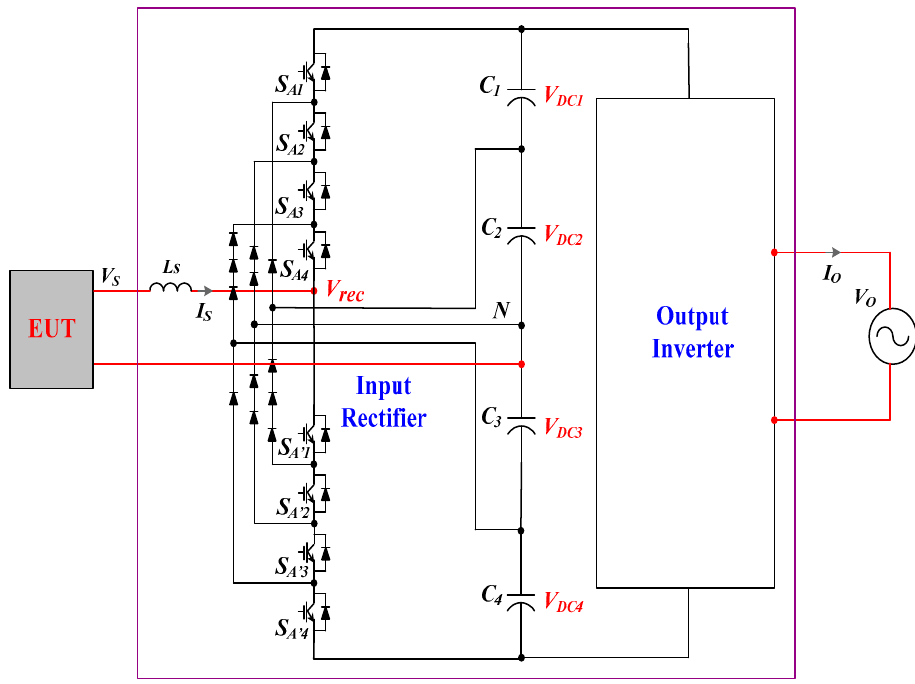
Figure 2. Single-phase five-level OCC MV Regen-Load power stage configuration.